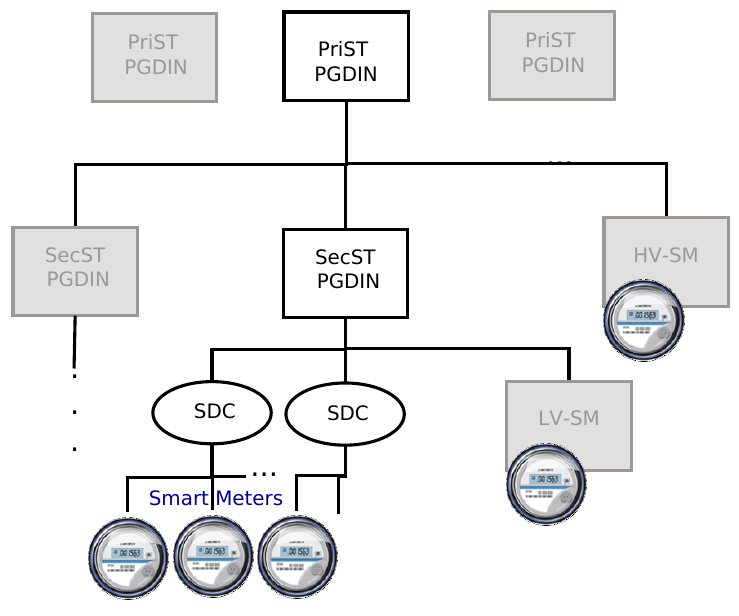
Figure 3. PGDINs involved in the energy imbalance billing